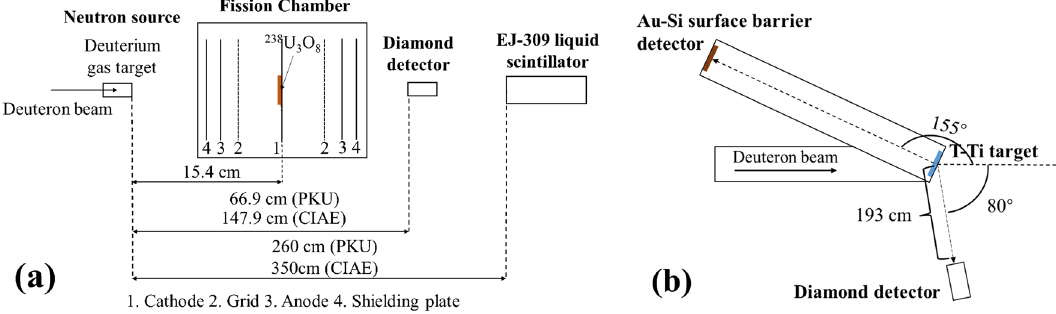
Figure 3. The setup of the experiments based on the d–d neutron source ( a ) and d–t neutron source ( b